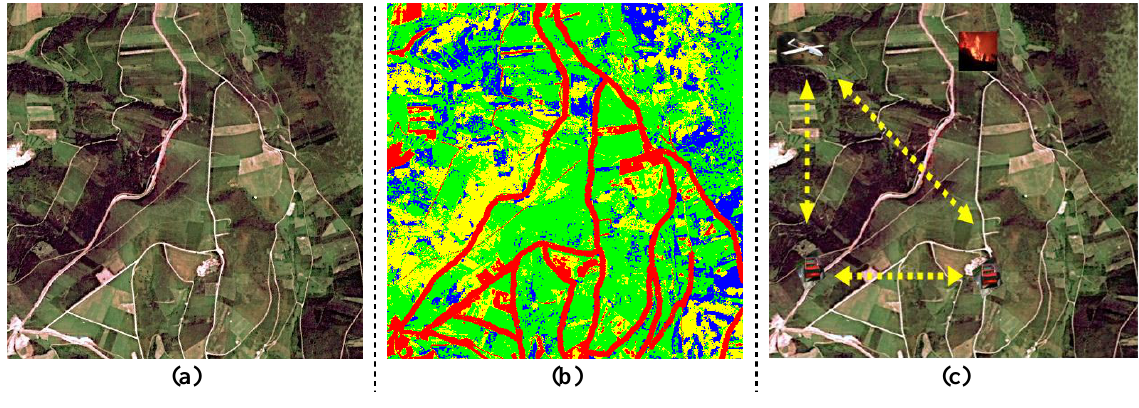
Figure 3. The fire fighting disaster intervention. (a) Picture taken from the UAV camera in optimal visibility conditions. (b) Semi-processed image with textures. (c) Path planning in the